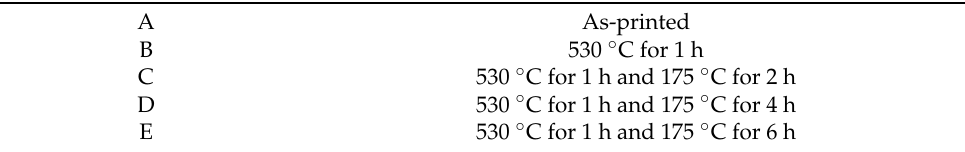
Table 3. Heat treatment parameters of the Al-Ni-Cu alloy before and after solution treatment.